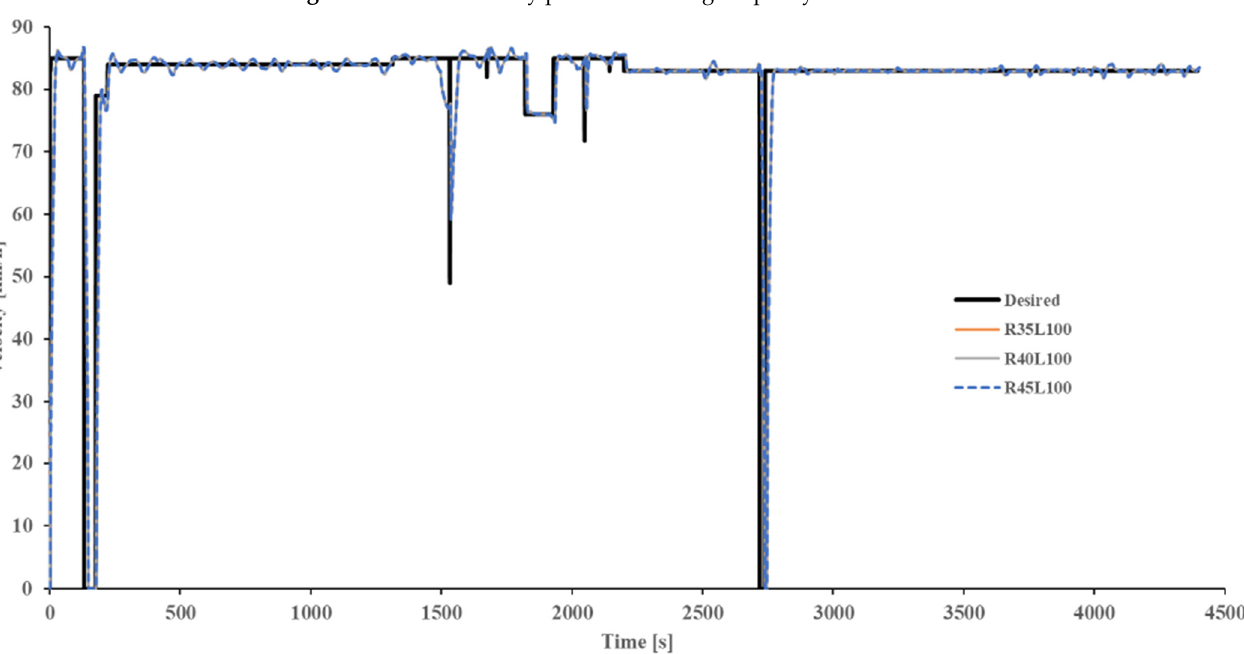
Figure 10. Truck desired and actual velocity for different case studies in various times in proposed driving cycle. driving